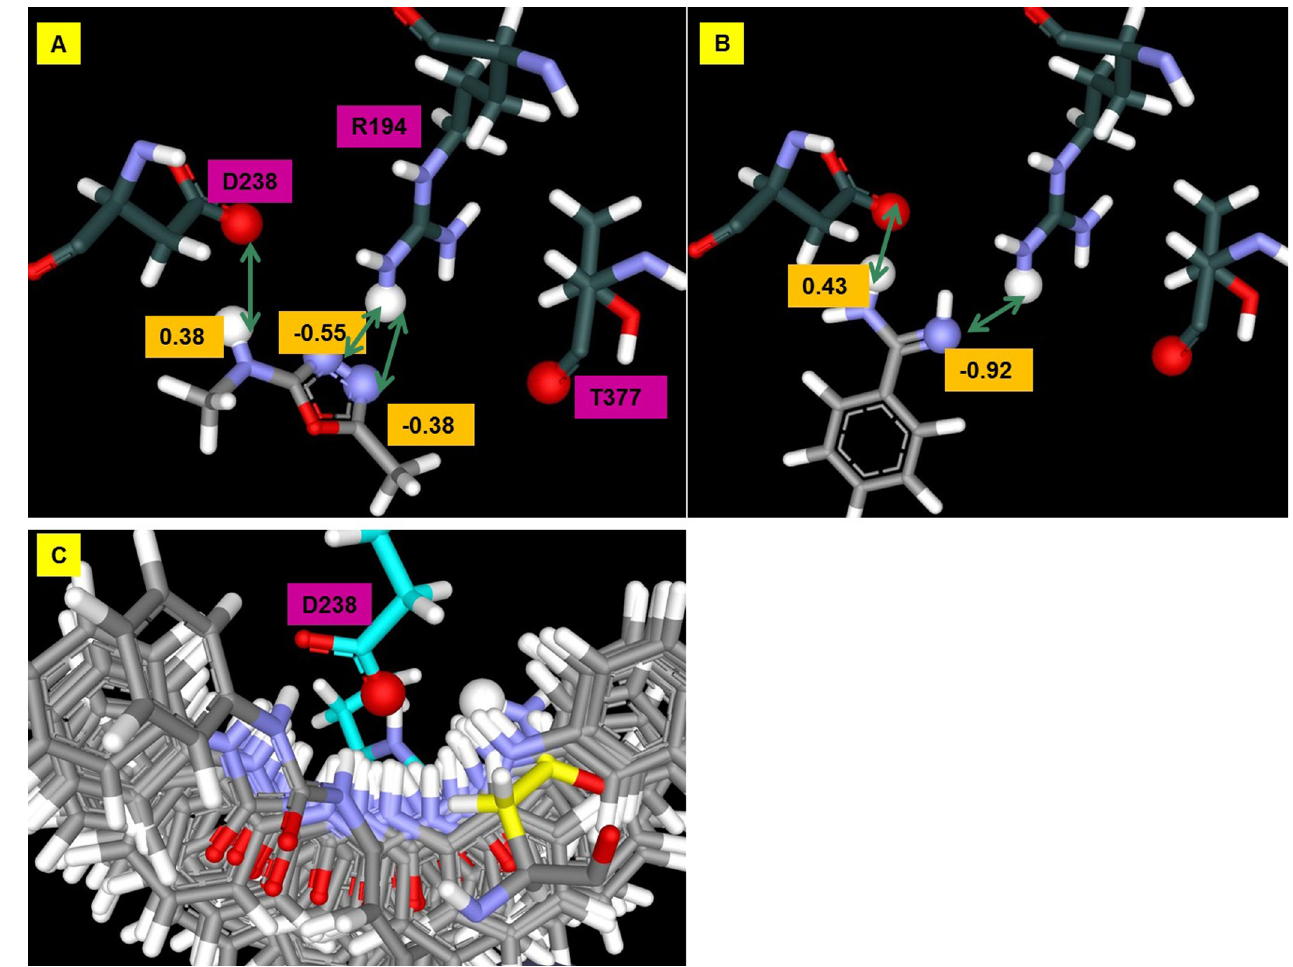
Fig 11. Much of the PCSK9 surface that interacts with LDLR is flat and featureless. Low affinity nondescript binding occurs with fragments like (A) dimethyl-oxadiazole and (B) benzamidine based on polar interactions (partial atomic charges shown in orange boxes) with R194-D238. The site is so highly exposed (C) that N,N’-diphenyl-urea can approach D238 from all